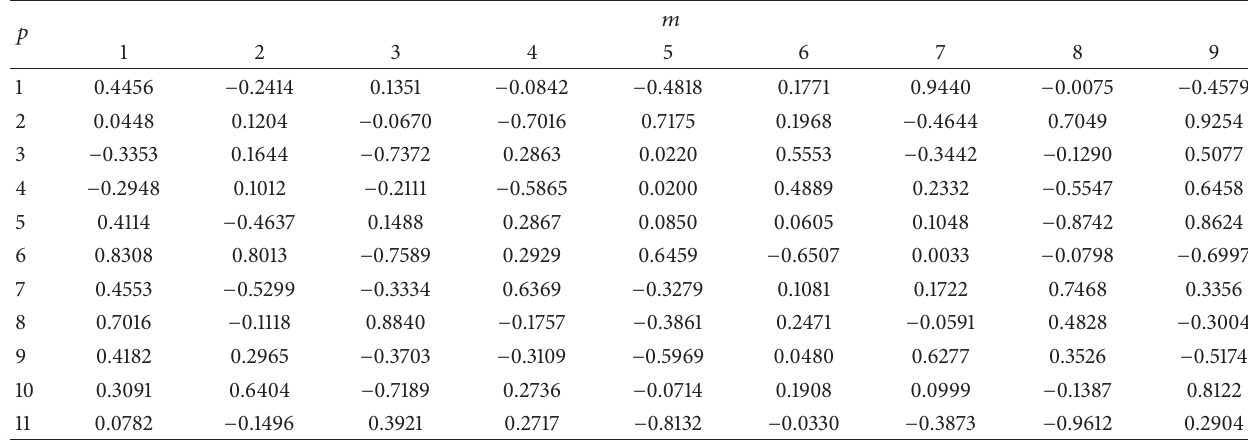
Table 1: Optimized input-to-hidden layer